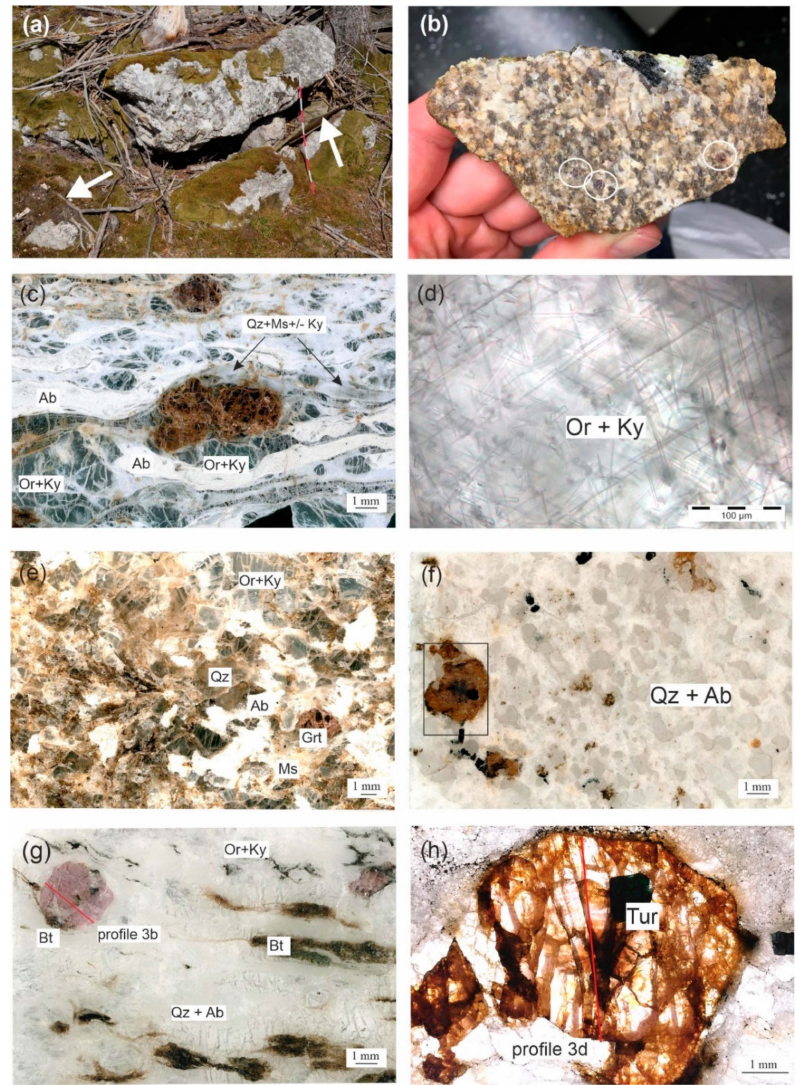
Figure 2. Petrography of selected pegmatite samples. ( a ) Outcrop situation showing pegmatite embedded in a micaschist host rock (white arrows). Scale bar is 1 m (sample W06). ( b ) Hand specimen showing granitic texture and average volumetric occurrence of garnet (white circles) (sample Kor_1). ( c ) Sigmoidal garnet porphyroclast surrounded by a mylonitic fabric consisting of recrystallized Qz + Ms ± Ky and Ab (sample W01). ( d ) Kyanite needles overgrown by ortho- clase, observed in samples W01, Kor_1 and Kor_3 (sample Kor_1). ( e ) Coarse-grained primary magmatic texture. Minerals are indicated (sample Kor_1). ( f ) Garnet embedded in quartz-albite ag- gregates. Details of garnet in Figure 2h (sample W06). ( g ) Fine-grained mylonitic texture consisting of Qz + Ab and Or + Ky grains. Garnet partly retrogressed to secondary biotite. Compositional profile line (red line) of garnet sample shown in Figure 3b is indicated (sample Kor_3). ( h ) Studied garnet from sample W06. Garnet with overgrown tourmaline crystals. Garnet profile (red line) shown in Figure 3d. Mineral abbreviations after Whitney and Evans